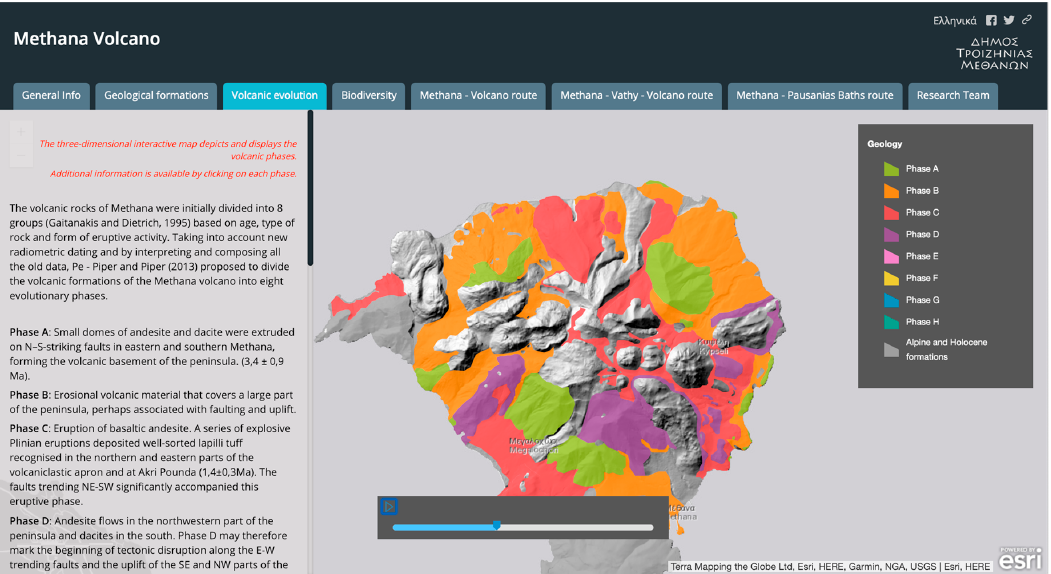
Figure 12. Screenshot of the third tab, where the volcanic evolution of the Methana peninsula is presented (https://goo.gl/DG36QU).